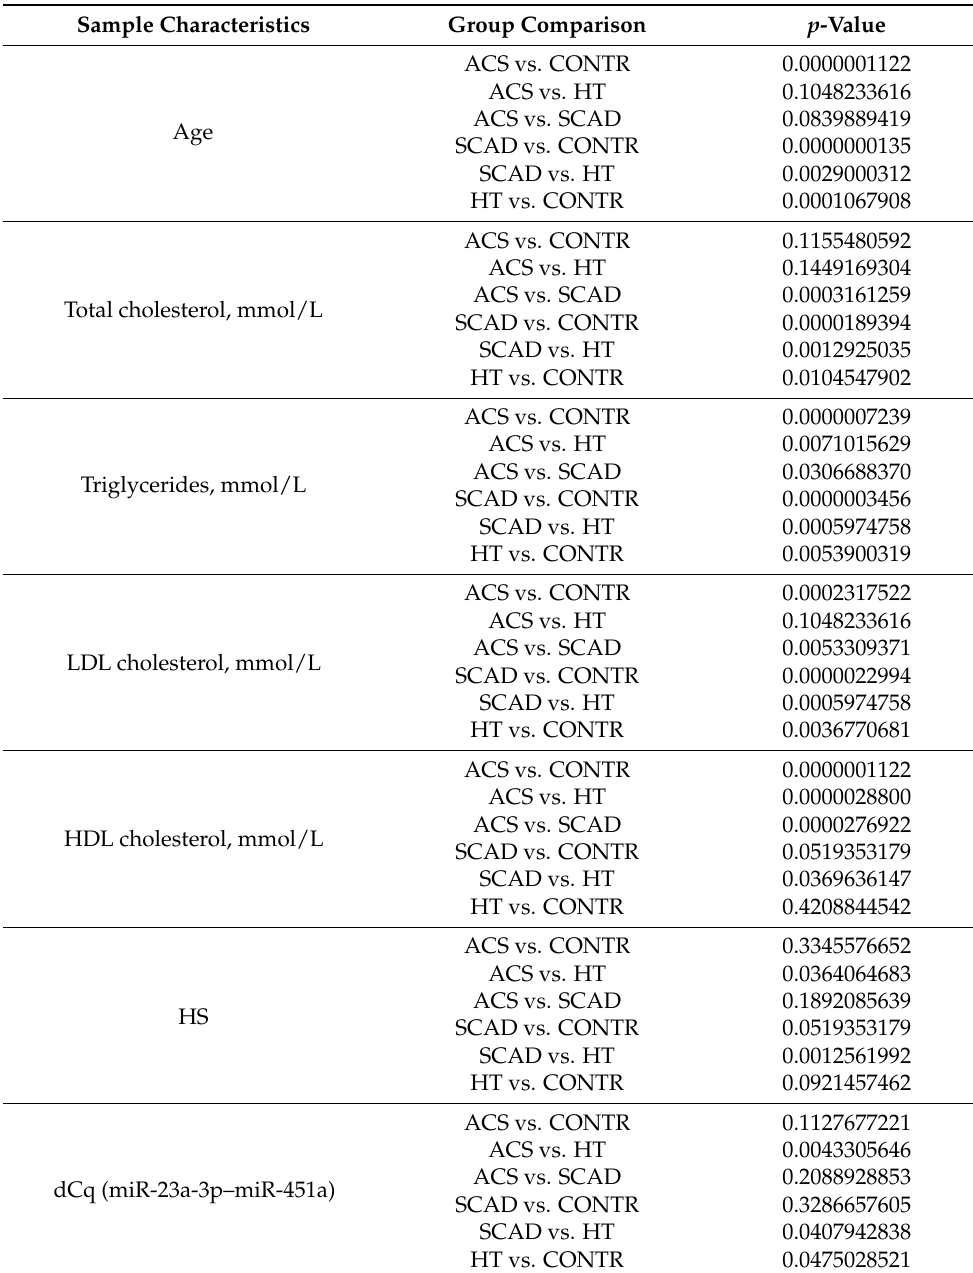
Table A1. Mann–Whitney (with the Bonferroni–Holm correction) p -values of significance for com- parisons of the study sample characteristics between the study sample groups: ACS, 50 ACS patients; SCAD, 26 patients with stable CAD; HT, 30 hypertensive patients without CAD; CONTR, 30 healthy controls. LDL, low-density lipoproteins; HDL, high-density lipoproteins; HS, hemolysis score;